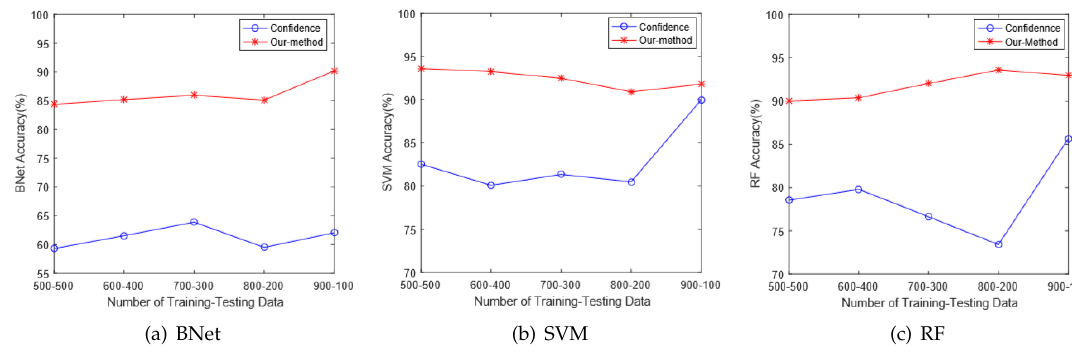
Figure 11. The impact of training and testing